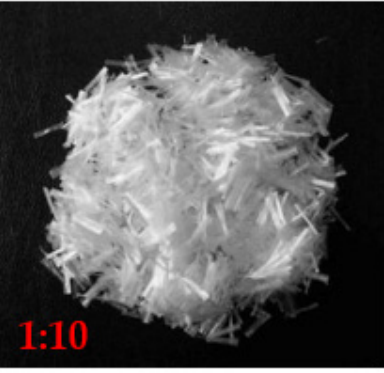
Figure 1. Coral aggregate. ( a ) Coral coarse aggregates. ( b ) Coral fine aggregates.